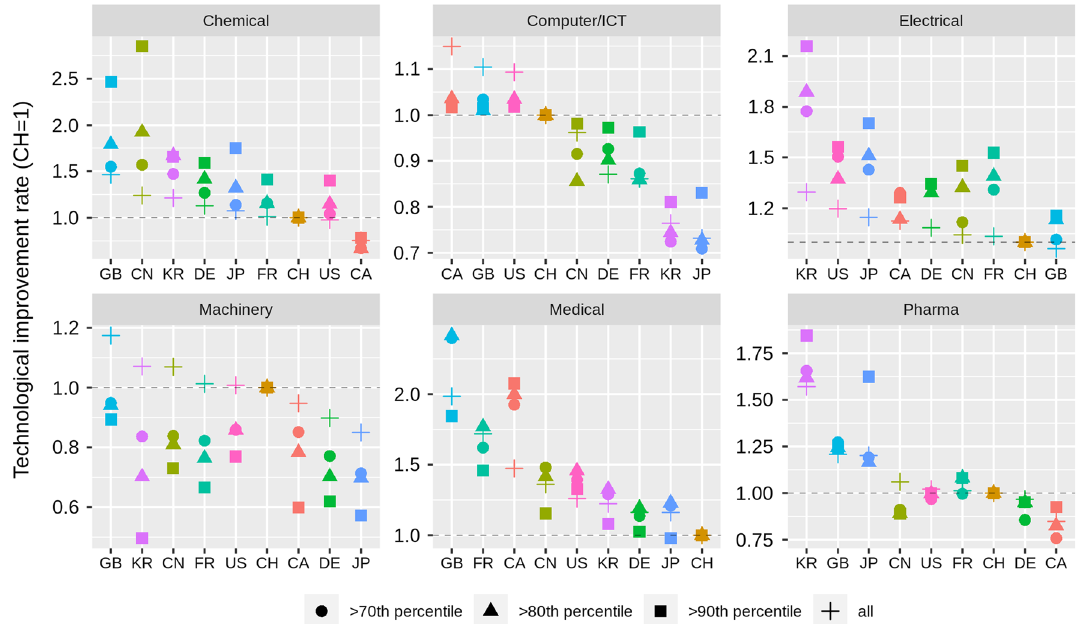
Fig. 8 Average technological improvement rates for digital patents across industries and countries for different percentile subsets. Notes : Calculations based on improvement rates of 1757 technologies taken from Singh et al. (2021) and the definition for digital IPC classes from Inaba and Squicciarini (2017) that were both matched to USPTO patents between 2010 and 2015. The average technological improvement rate is normalized according to the value of Switzerland. The plot shows average improvement rates for patents whose improvement rate is above the xth percentile of a given country. For comparison, the dots labelled as all show the averages across all patents as used in the main